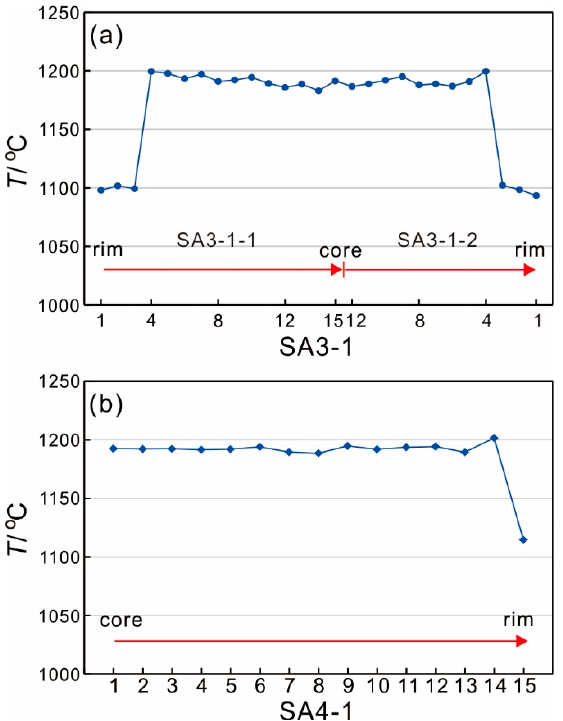
Figure 10. Diagram of the estimated crystallization temperatures of zoned plagioclase phenocrysts. The crystallization temperatures from core to rim decreased sharply for typical plagioclase phenocrysts. ( a ): sample SA3–1; b ): sample SA4–1.